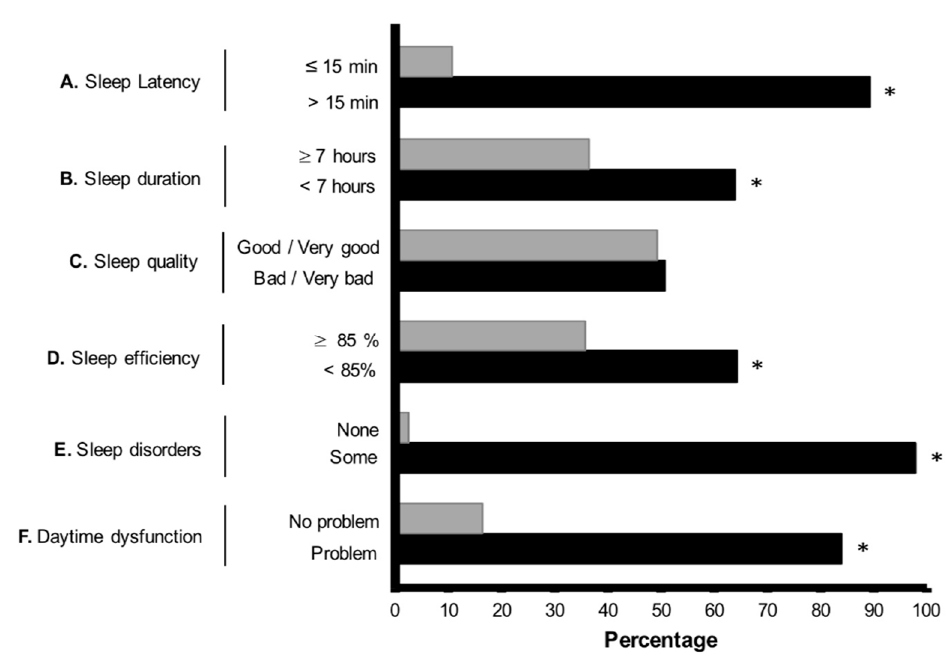
Figure 1. Percentage of responses given for the Pittsburgh Sleep Quality Index items. * Indicates significant differences at p < 0.001 when the exact binomial test was applied.